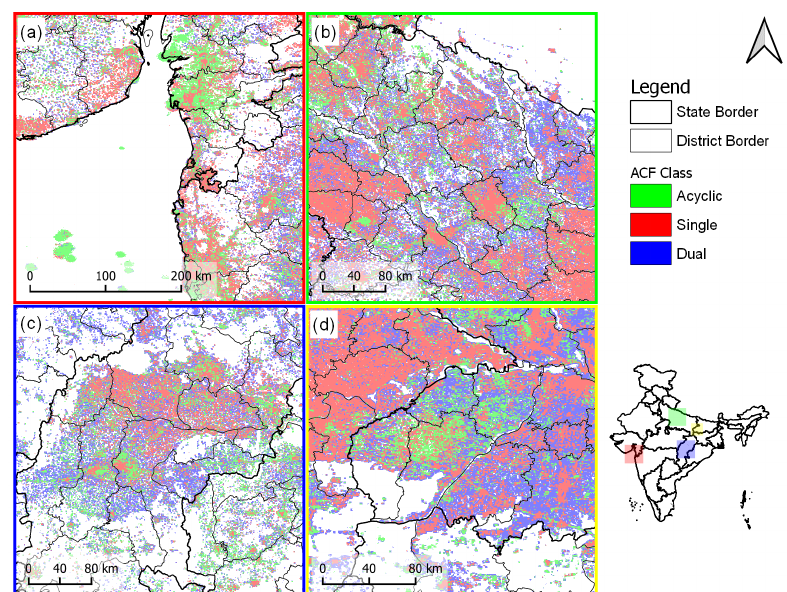
Figure 24. Regions with the supervised ACF classification results of interest. Lit area mask applied. ( a ) Region covering the gulf of Khambhat. ( b ) Central Uttar Pradesh covering Lucknow. ( c ) Central Chhattisgarh state covering Raipur. ( d ) Southwestern